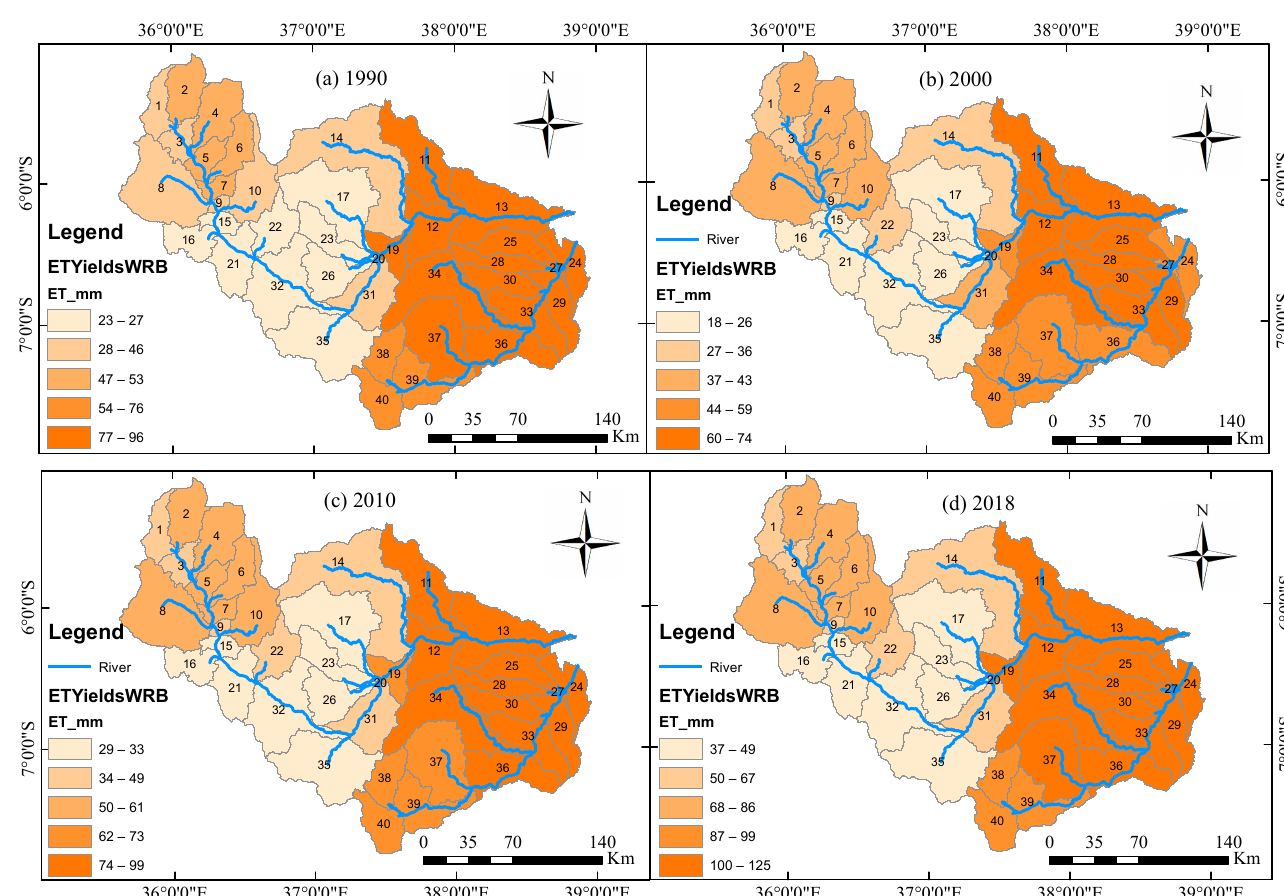
Figure 10. The temporal trends of simulated ET in the WRB.